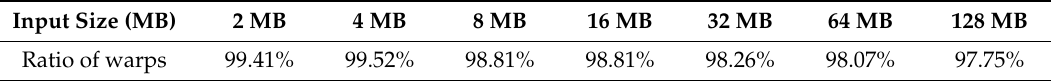
Table 2. Ratios of warps with less than 3 active threads in execution after five matchings.